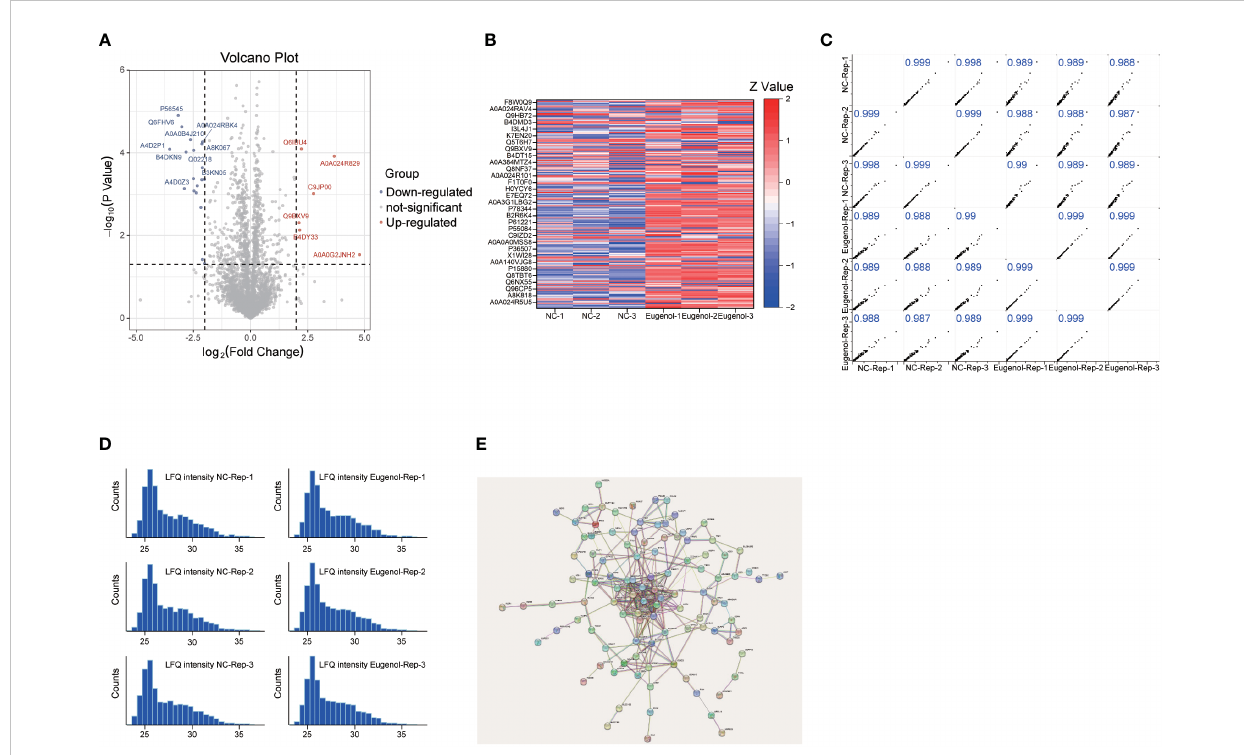
FIGURE 3 Lable-free proteomics reveals the anti-tumor mechanism of eugenol. (A) Volcano plot of identi fi ed proteins. The blue dot represented the down- regulated protein, the red dot represented the up-regulated protein, and the gray dot represented the protein with no signi fi cant difference. Student ’ s t-test (P value ≤ 0.05); (B) Heatmap of the differentially expressed proteins in two groups; (C) Pearson correlation showed clustering of samples replicate reproducibility; (D) The distribution of peptide length. (E) STRING PPI network analysis of the differentially changed